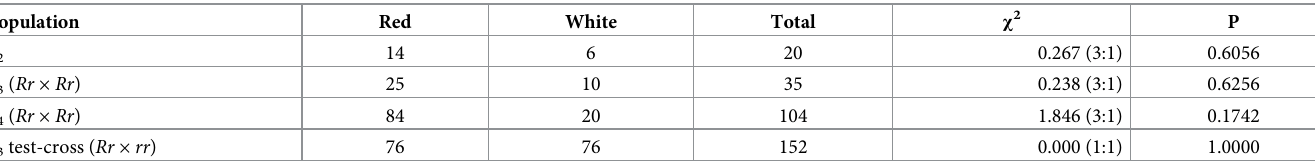
Table 3. Root skin color segregation.